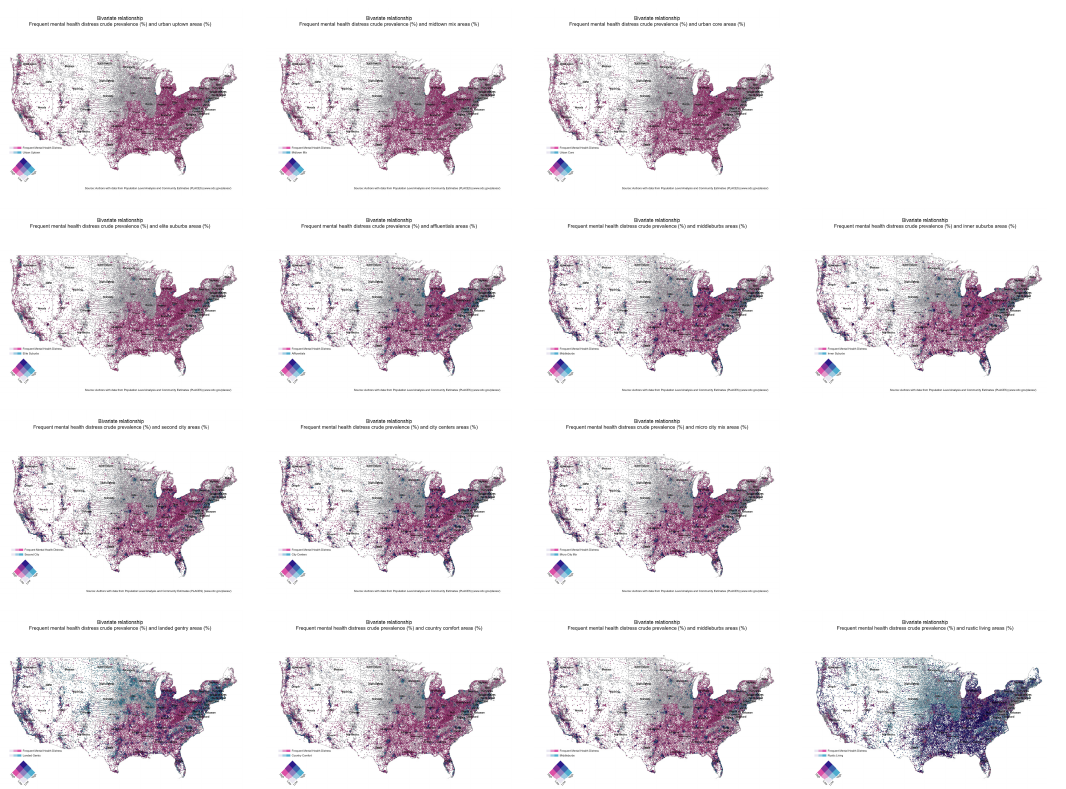
Figure 2. Bivariate choropleth maps between the crude prevalence of frequent mental health distress and individual social groups. A pink shade indicates a high spatial concentration of frequent mental health distress, while a light blue indicates a high geographic presence of a particular social group. A dark blue shade suggests a high spatial concentration of both frequent mental health and a par- ticular social